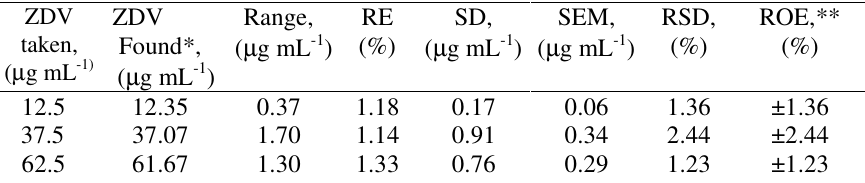
Table 2 . Evaluation of accuracy and precision .